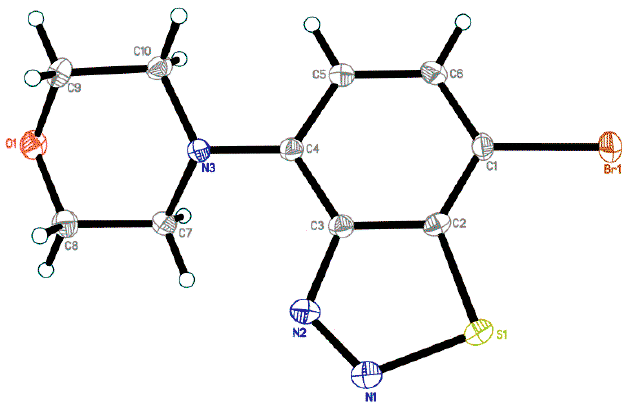
Figure 1. X-Ray structure (ORTEP at 50% level) of 4-(7-bromobenzo[ d ][1,2,3]thiadiazol-4-yl)morpholine 2 .